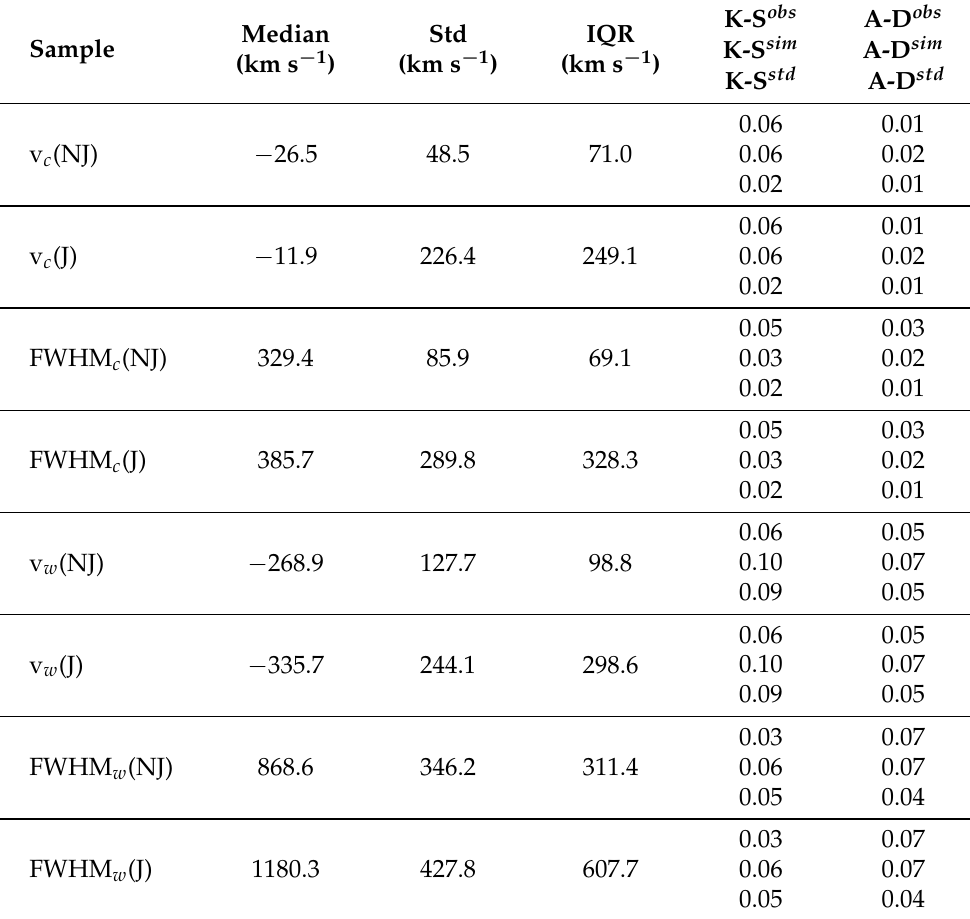
Figure 3. Left: distributions of the [O III] core velocity shift in km s − 1 , in non-jetted (top panel) and jetted sources (bottom panel). The vertical dashed lines indicate the limits for red or blue outliers at 150 km s − 1 . Binning of 25 km s − 1 . Right: distributions of the FWHM([O III]) core component in km s − 1 , in non-jetted (top panel) and jetted sources (bottom panel). Binning of 25 km s − 1 . Table 5. Results of the statistical tests for the spectral index samples. Columns: (1) Tested sample; (2) median velocity; (3) standard deviation of the velocity; (4) interquartile range; (5) p -value of the K-S tests against the other sample, observed in top row, simulated in middle row, and standard deviation of the simulated p -value in the bottom row; (6) p -value of the A-D tests against the other sample, observed in top row, simulated in middle row, and standard deviation of the simulated p -value in the bottom